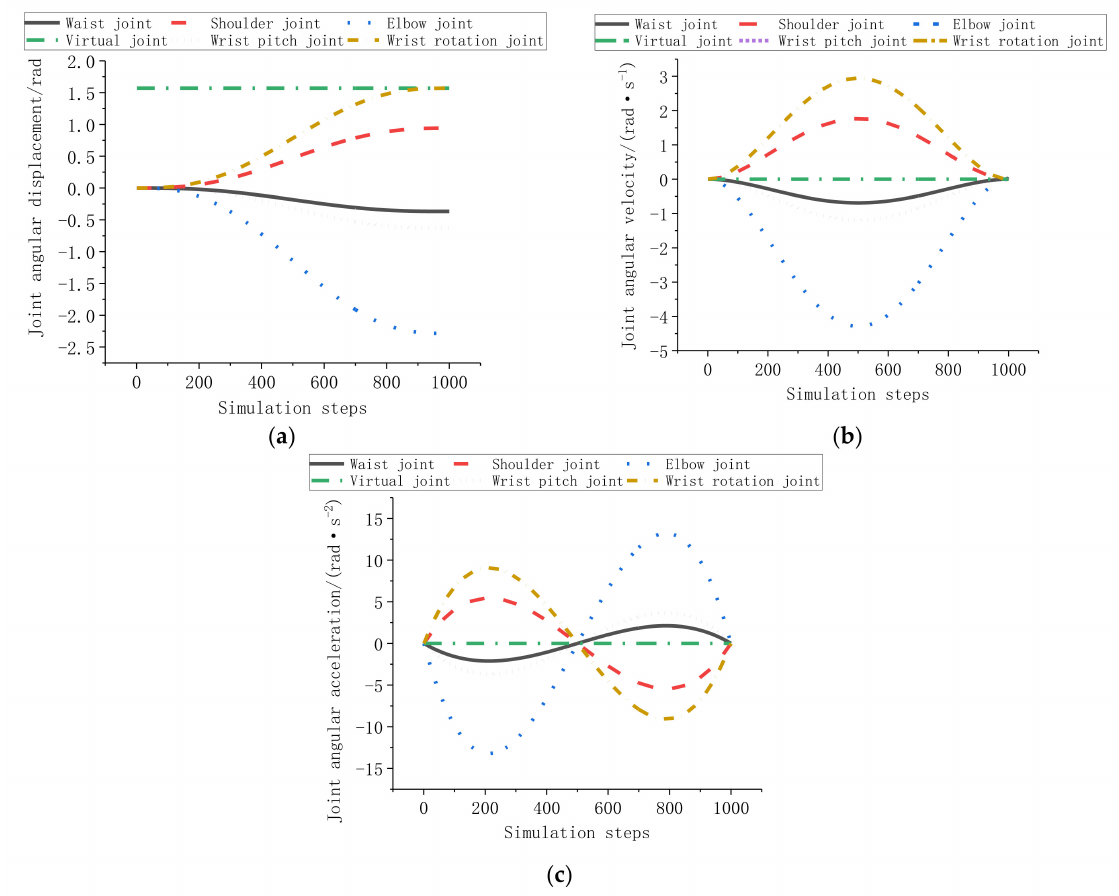
Figure 7. ( a ) Angular displacement curve of each joint; ( b ) Angular velocity curves of each joint; ( c ) Angular acceleration curves of each joint.